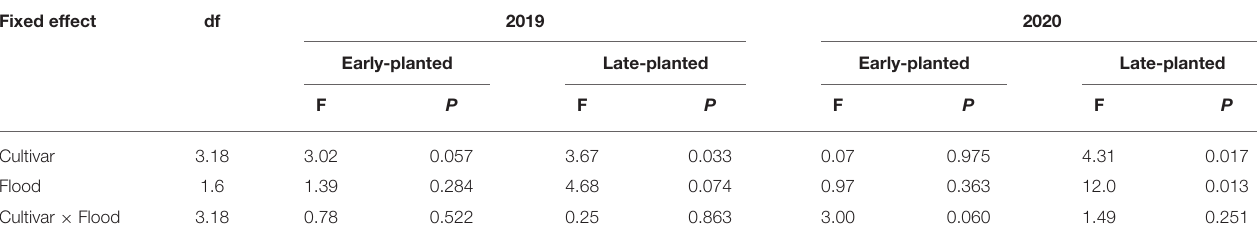
TABLE 4 | Results of general linear mixed models (GLIMMIX) for yield loss in 2019 and 2020 field trials at Crowley,